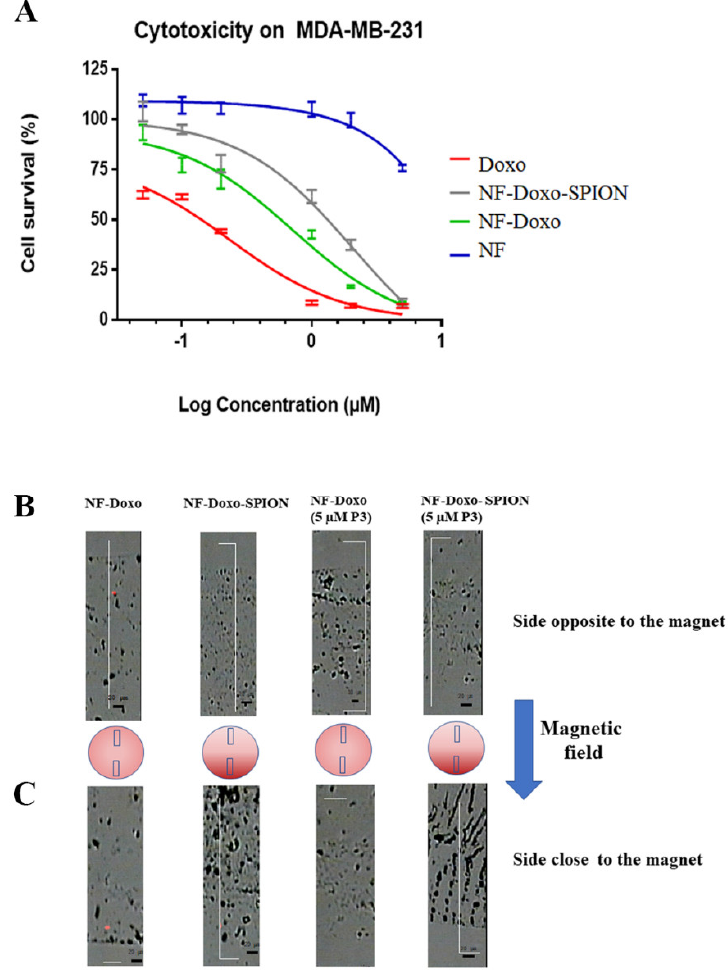
Figure 10. Comparison of cytotoxicity plots on breast cancer cells of the nanofibers ( A ). Images recorded by LabRaman confocal microspectrometer on two sides of the drop analyzed for each sample, on the side opposite to magnet ( B ) and another on the side close to the magnet ( C ). Table 4. IC 50 (μM) values on MDA-MB-231.